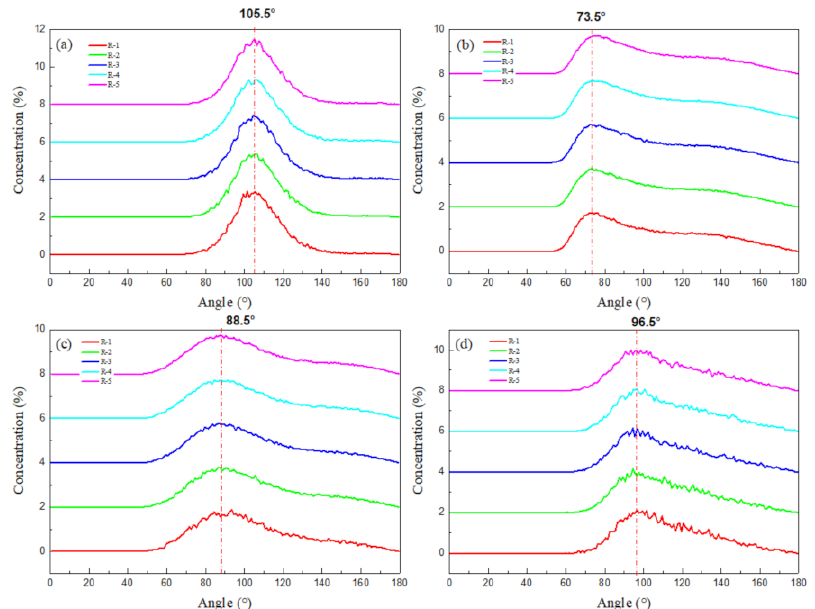
Figure 9. Distribution of bond angles of ( a ) O-Si-O, ( b ) O-Al-O, ( c ) Al-O-Al, and ( d )